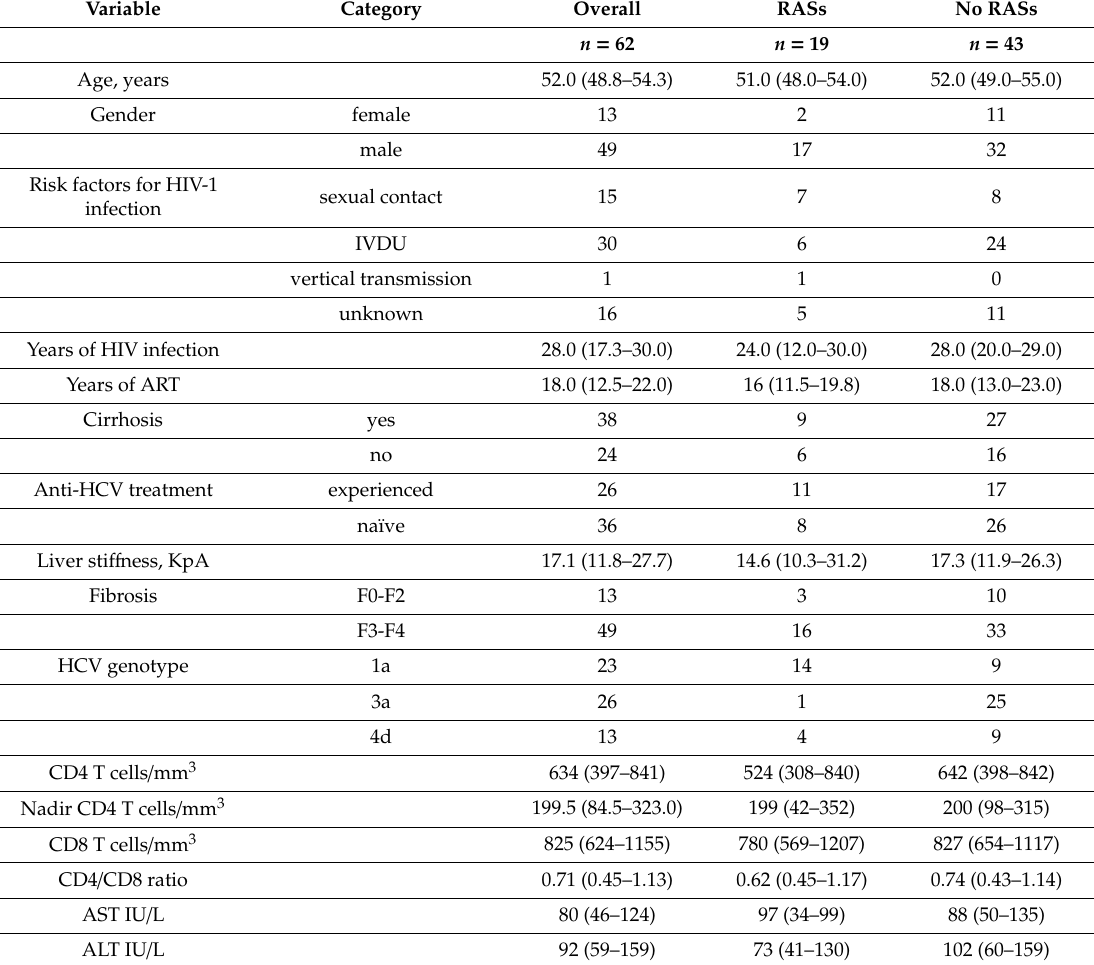
Table 1. Baseline characteristics of HIV1 / HCV coinfected patients with or without resistance-associated substitutions (RASs in the NS3 and / or NS5a